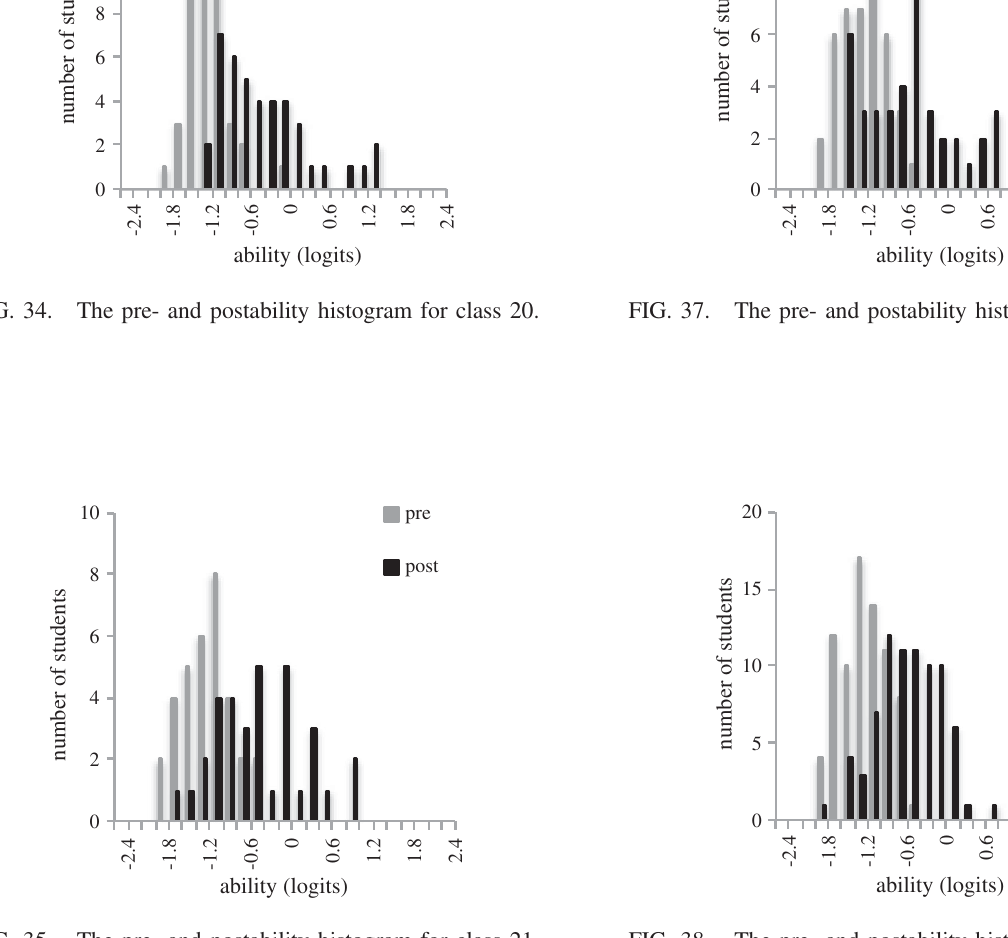
FIG. 35. The pre- and postability histogram for class 21.